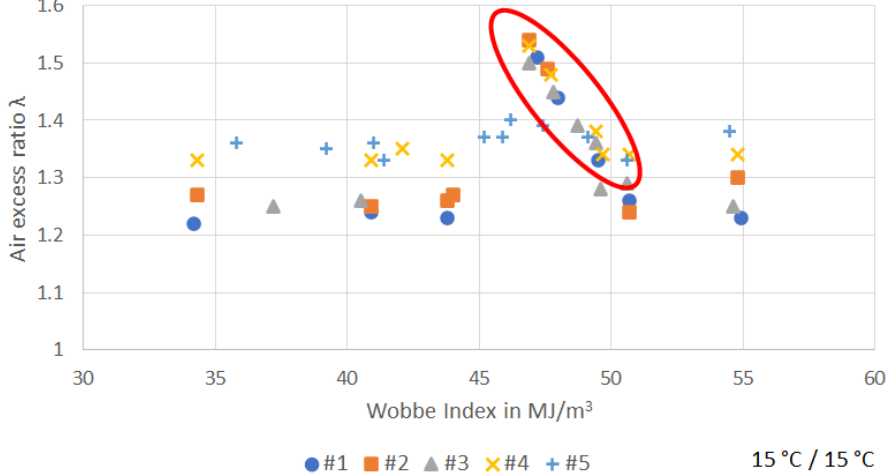
Figure 8. Impact of changing Wobbe Indices on the air excess ratio in gas appliances with combustion control. The highlighted data points show where the Wobbe Index change was due to H 2 admixture. The different colors indicate different combustion-controlled appliances. Recreated from [28].